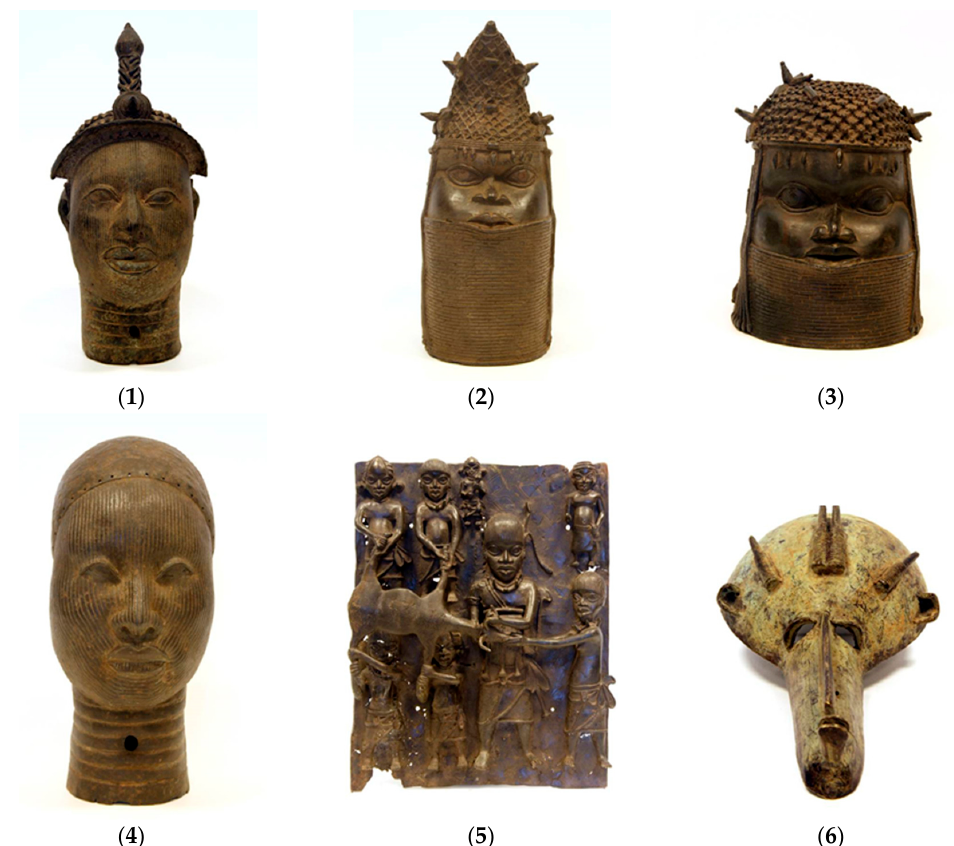
Figure 6. Various brass objects of alleged Benin and Ife provenance (photo: Andreas Schwabe). Top, from left to right ( 1 ) (93) Oni (Ife) head, ca. 1450; ( 2 ) (89.2) Queen Mother (Benin), ca. 1650; ( 3 ) (89.3) head with coral hood (Benin), ca. 1600; ( 4 ) (100) Ife head, ca. 1430; ( 5 ) (58.2) relief with animal sacrifice (Benin), ca. 1620; ( 6 ) (39) mask (Mali?), ca. 1650.